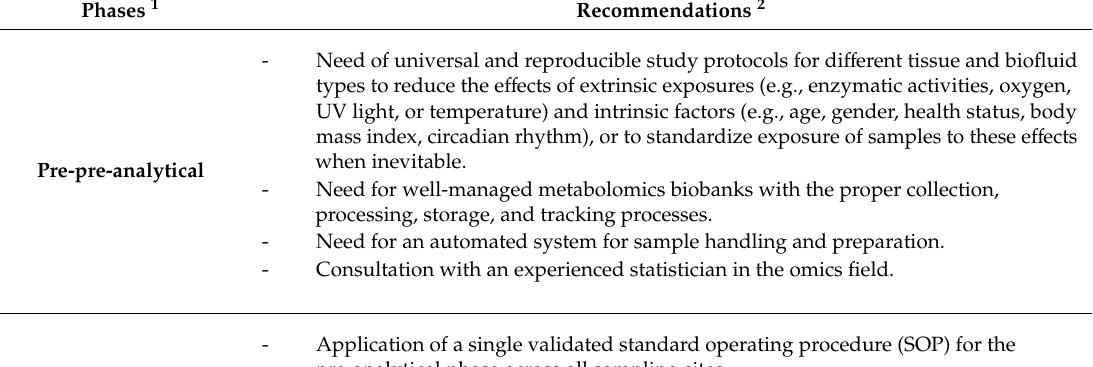
Table 2. Additional recommendations to ensure QA / QC procedures in metabolomics and lipidomics study at clinical and epidemiological